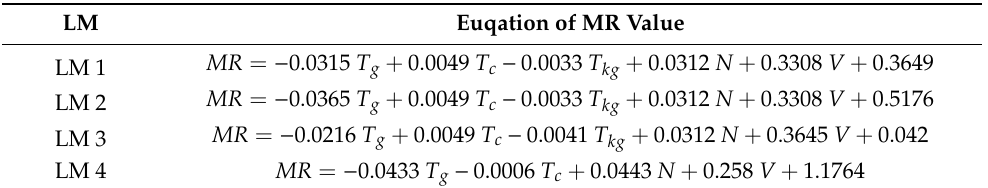
Table 5. Linear model (LM) equations of MR values in the decision tree algorithm.